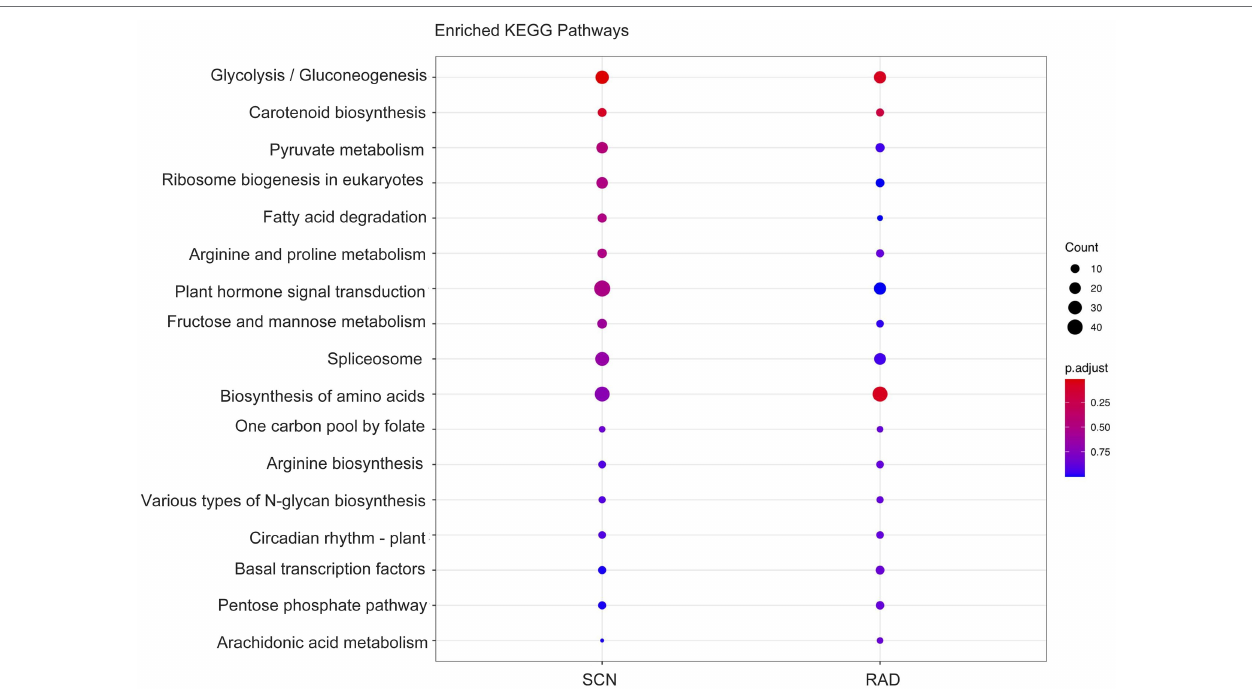
FIGURE 5 | KEGG enrichment of genes located 100 Kbp upstream and downstream of lncRNAs.